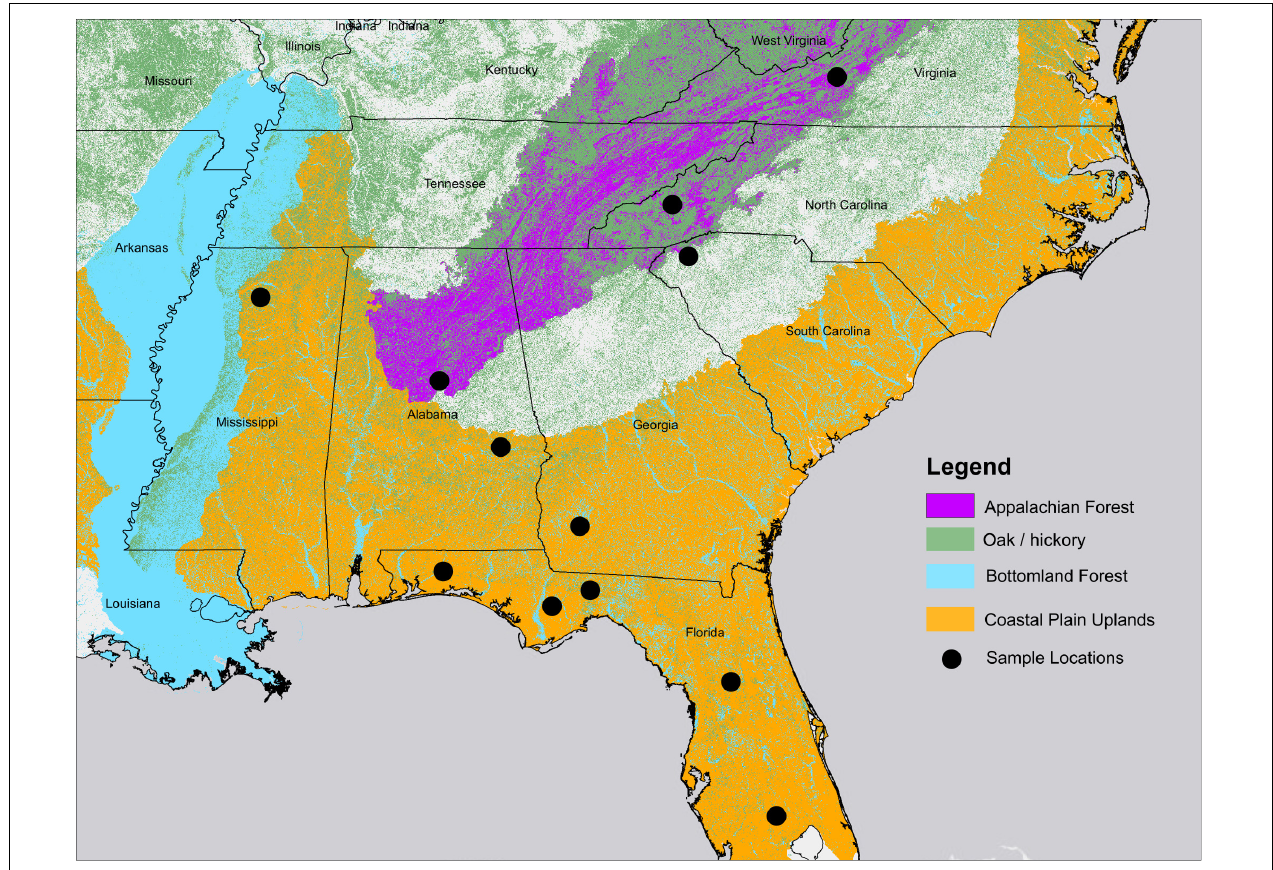
FIGURE 1 | Geographic range of forest types and sample locations used in flammability analysis. Forest types were adapted from United States Forest Inventory and Analysis Forest Types and EPA Ecoregions (USEPA,